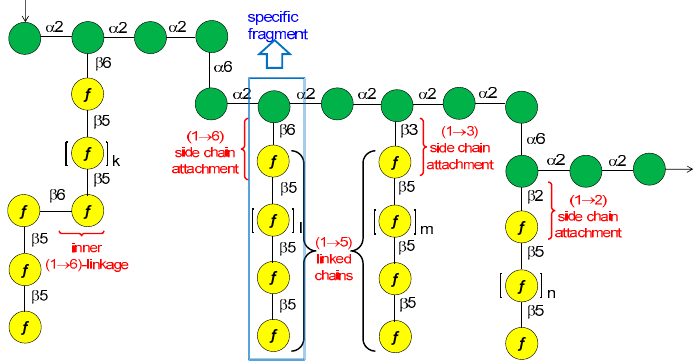
Figure 37. A. fumigatus galactomannan structure, underlining the presence of β -(1,6)-linked Gal f